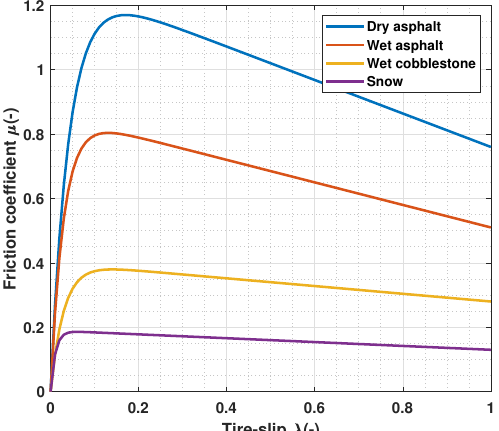
Figure 3. Friction coefficient for different road condition according to the Burckhardt model. Table 1. Burckhardt friction model parameters [34]. Burckhardt Parameters